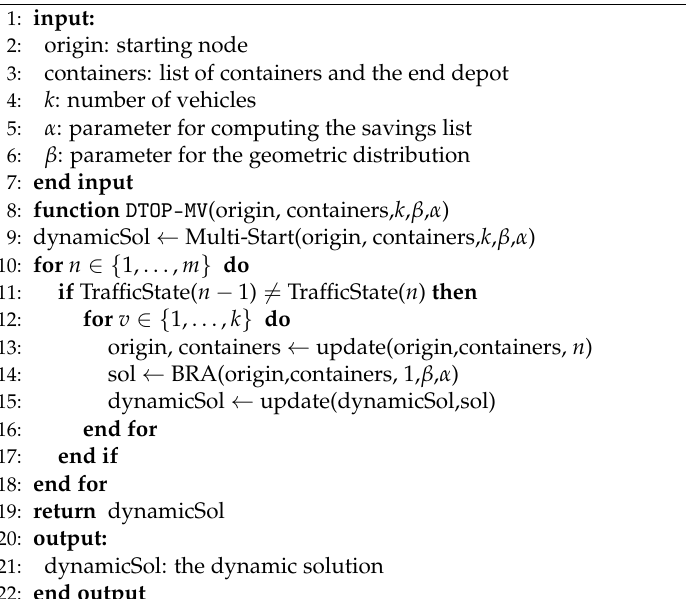
Algorithm 2 Planning Horizon approach for solving